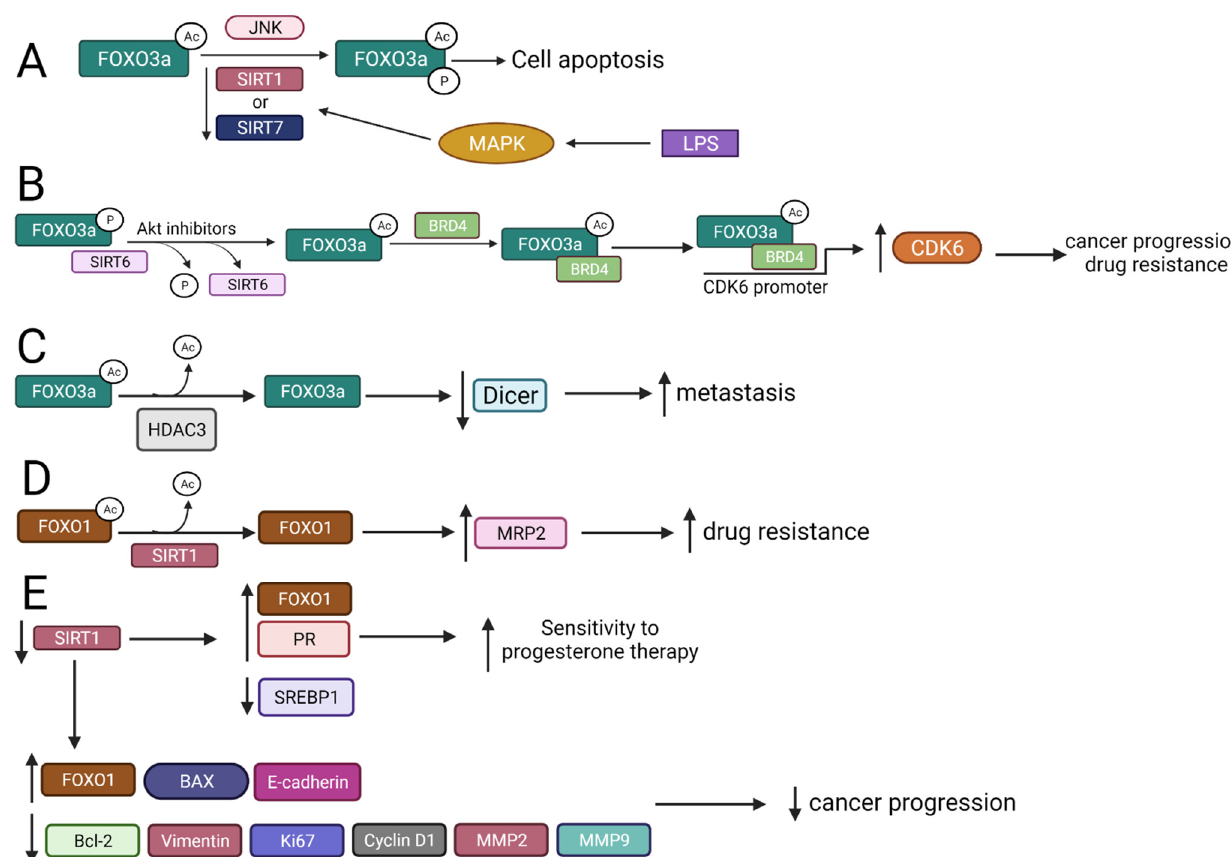
Figure 3. The interplay between SIRTs, HDACs, and FOXOs and the biological results of these interactions. ↑ —upregulation, ↓ —downregulation ( A ) Downregulation of SIRT1 and SIRT7 by LPS treatment increases FOXO3a acetylation and phosphorylation, which induces apoptosis. ( B ) Akt inhibitors interrupt phosphorylated FOXO3a–SIRT6 interaction, leading to FOXO3a acetylation and BRD4 binding, promoting upregulation of CDK6, cancer progression, and drug resistance. ( C ) FOXO3a is deacetylated by HDAC3, which leads to Dicer downregulation and enhances metastasis. ( D ) SIRT1 deacetylates FOXO1, leading to MRP2 upregulation and enhanced drug resistance. ( E ) Downregulation of SIRT1 upregulates FOXO1, leading to increased sensitivity to progesterone therapy, and modulates expression of genes involved in the regulation of cancer growth, angiogenesis, cell survival, EMT, cell proliferation, and cancer invasion.LPS—lipopolysaccharide; BRD4—bromodomain-containing protein 4; CDK6—cyclin dependent kinase 6; MRP2—multidrug resistance protein 2; EMT—epithelial-mesenchymal transition.